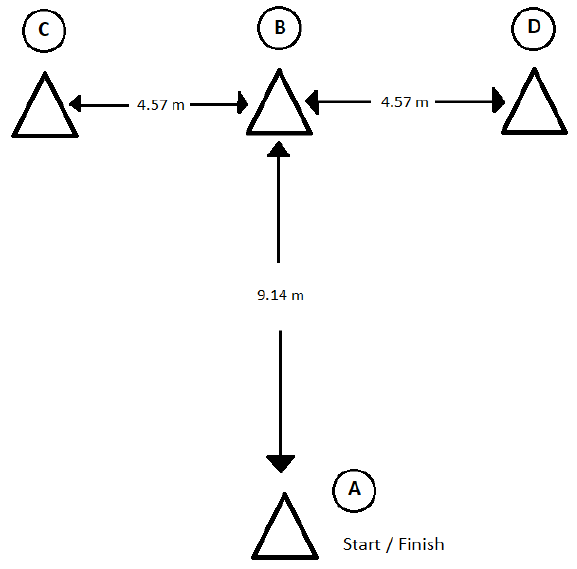
Figure 1. The course of modified agility T-test.